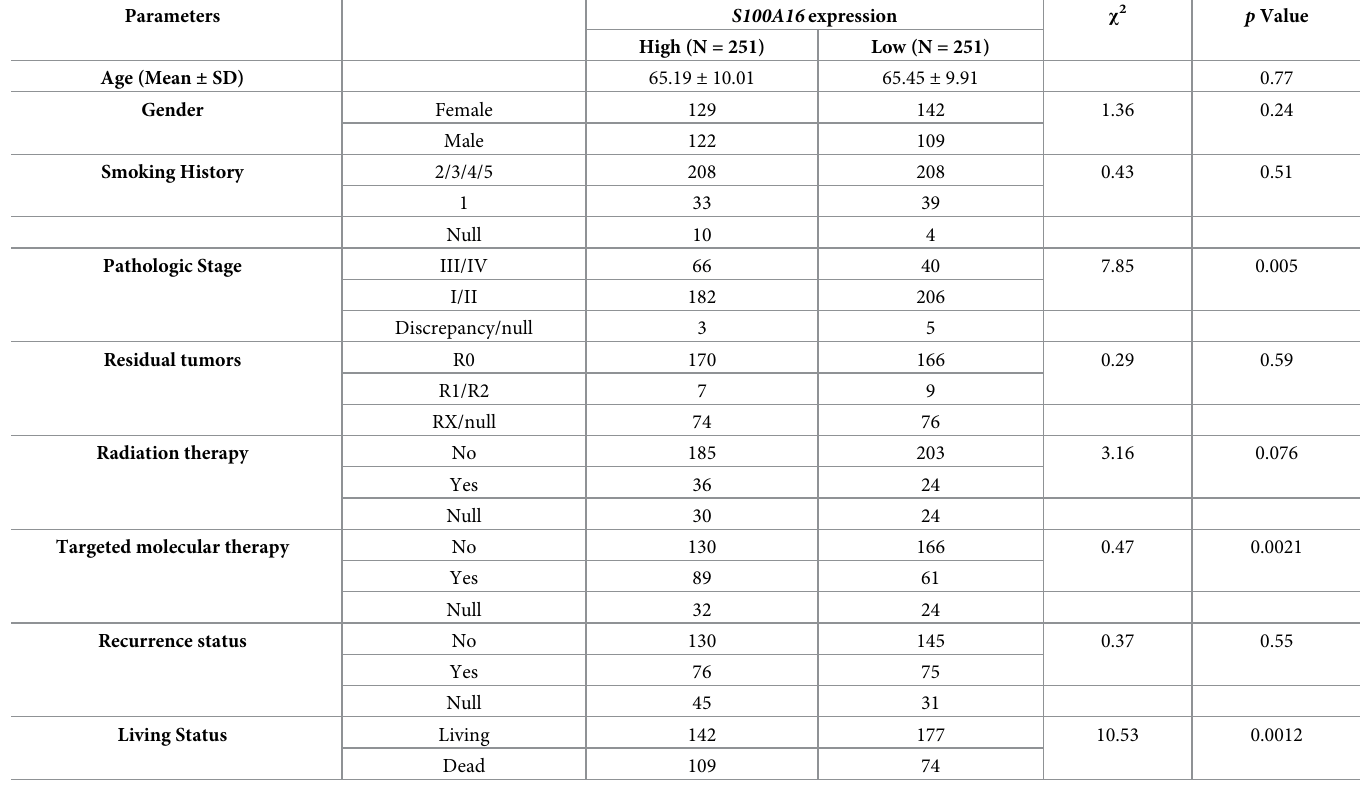
Table 1. Comparison of the clinicopathological parameters between high and low S100A16 expression groups. Parameters